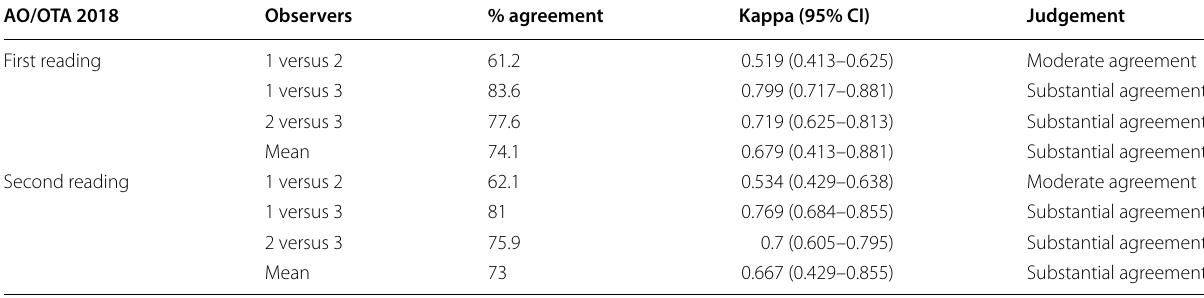
Table 3 Level of agreement among observers for the AO/OTA 2018 classification after both review